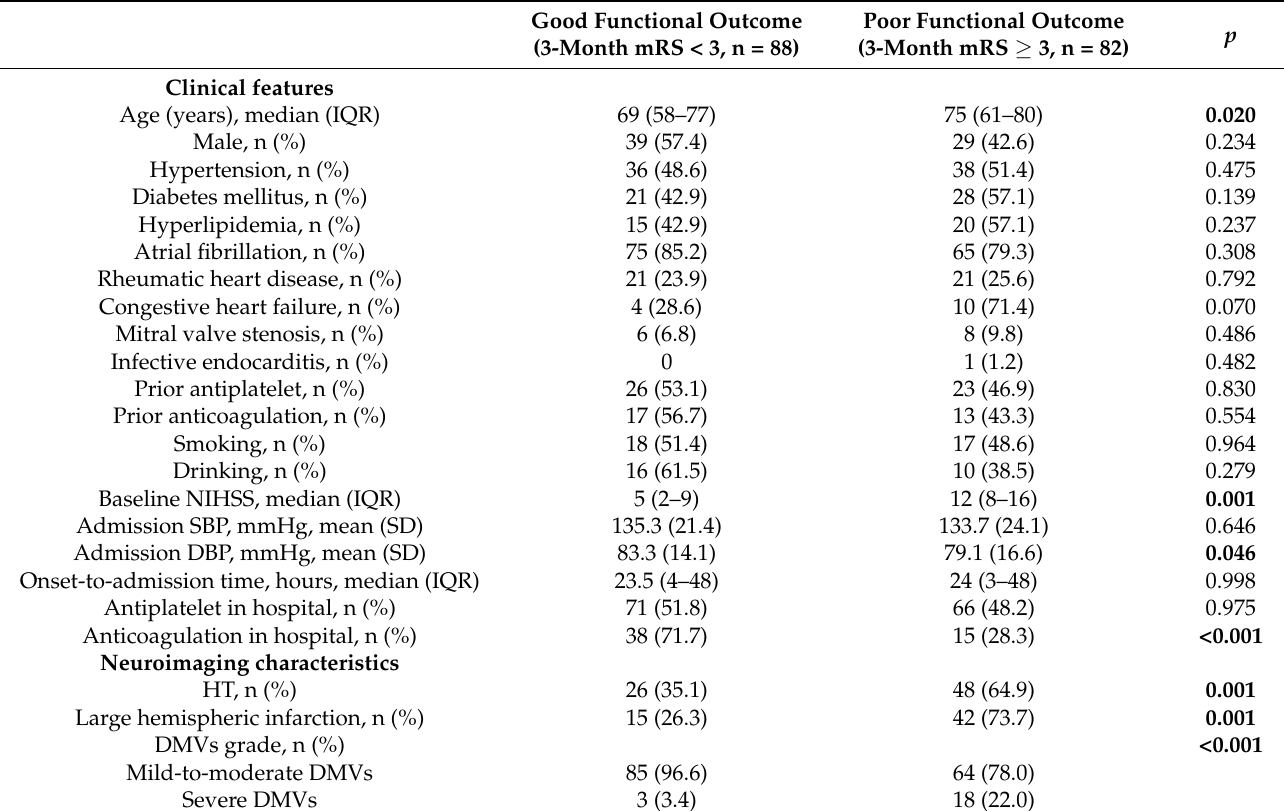
Table 2. Differences of clinical features and neuroimaging characteristics between the two functional outcome